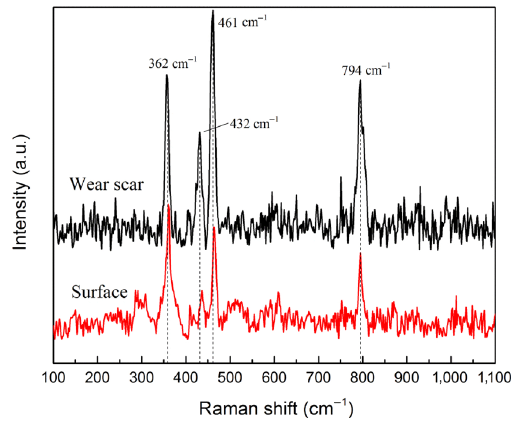
Fig. 35 Raman spectra of wear scar and surface of composites with BP content of 15 wt%.